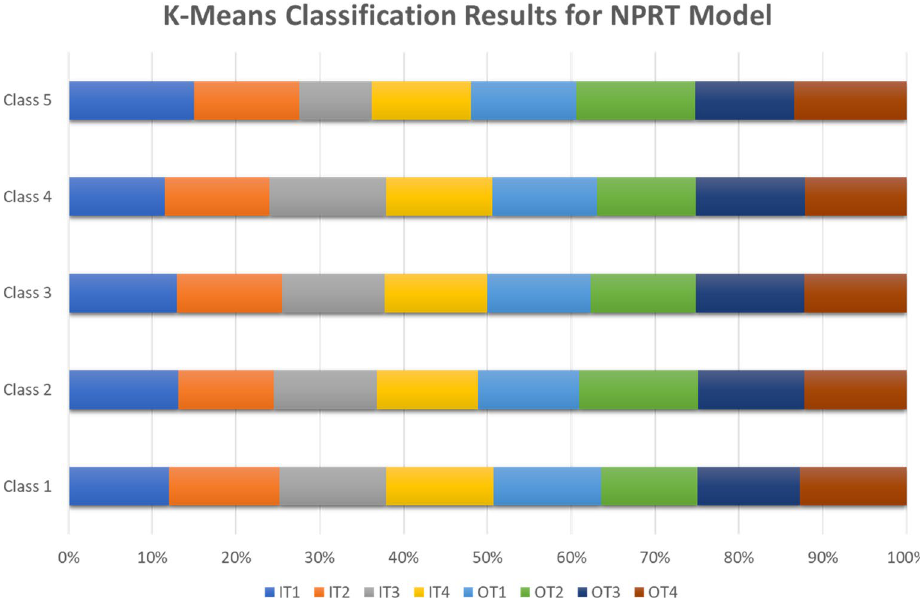
Figure 6. Number of stations in K-Means classification method for NPRT